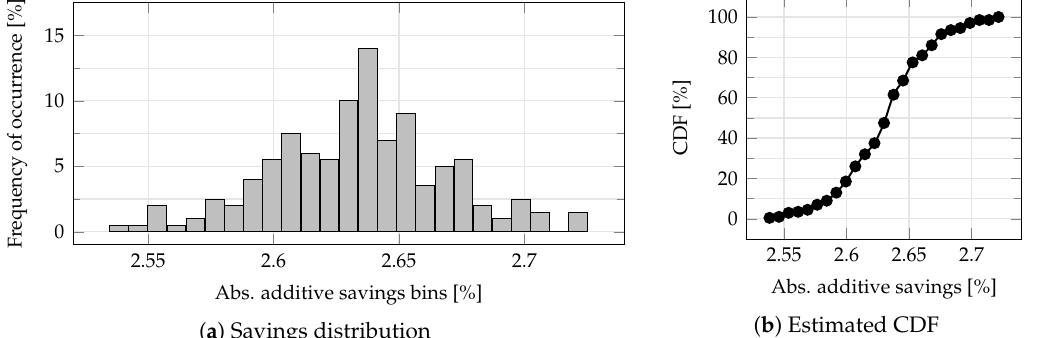
Figure 10. Histogram illustrating the distribution of the absolute additive savings in 25 bins for the considered realistic use case ( a ) and the corresponding estimate of the cumulative distribution function ( b